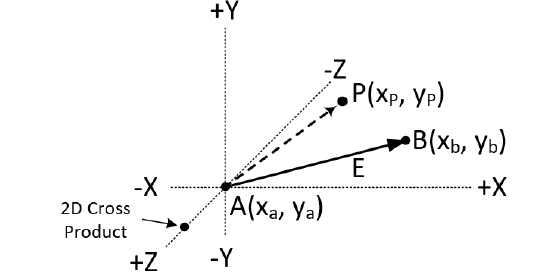
Figure 35. Using the 2D cross product to determine the position of the point P comparing to the line segment E